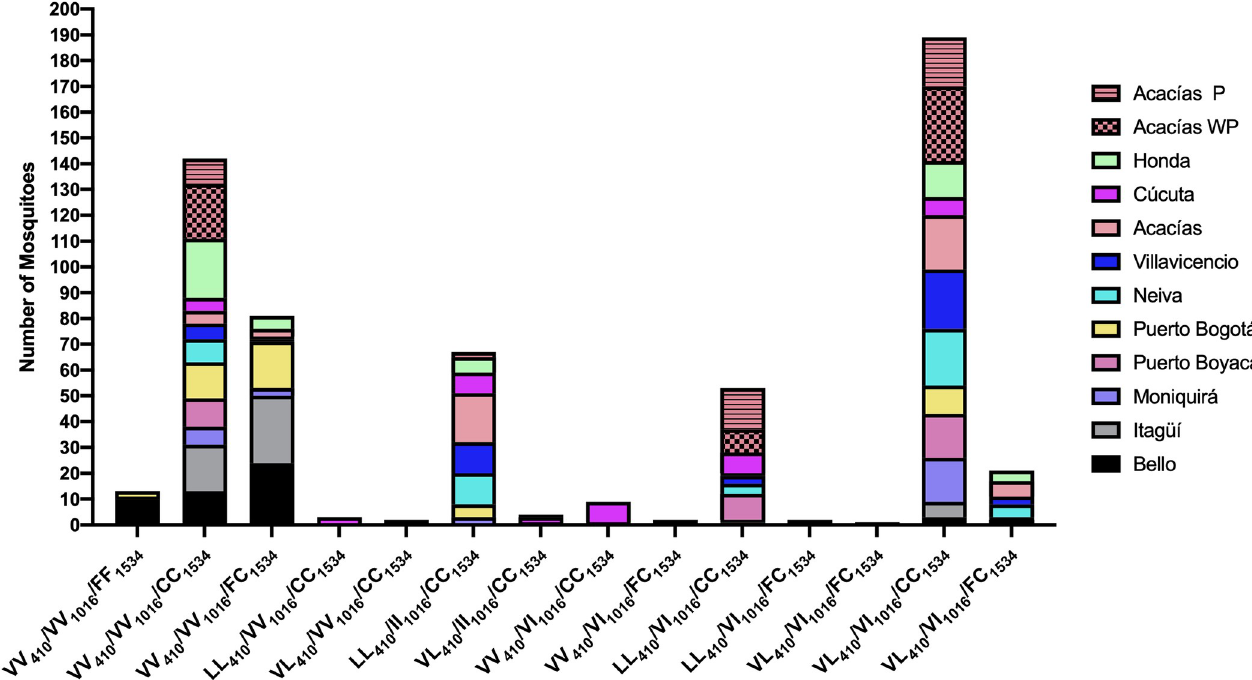
Fig 4. Genotypes observed in Colombian Aedes aegypti